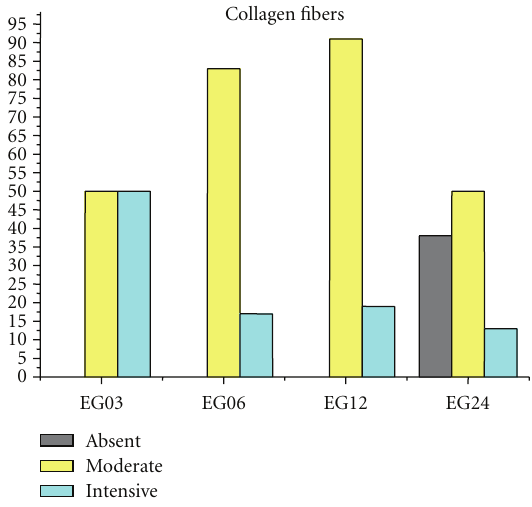
Figure 8: Longitudinal sections of samples containing the PVA implants. (a) EG03-presence of granulation tissue (GT); (b) EG06- presence of collagen fibers (CF); (c) EG12-presence of mineralized bone matrix (BM); (d) EG24-presence of neoformed bone tissue (NB). at = absence of tissue over the implant surface. Stained with Hematoxylin and Eosin.